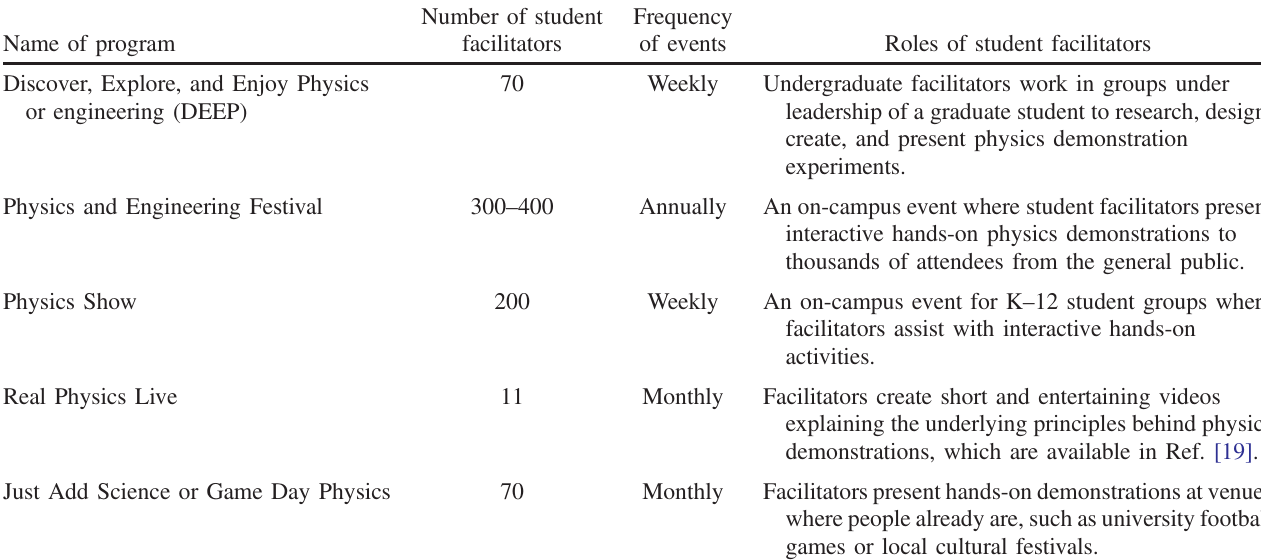
TABLE I. Informal physics programs at Texas A&M University included in this study. For more information on specific programs please see Rethman et al.